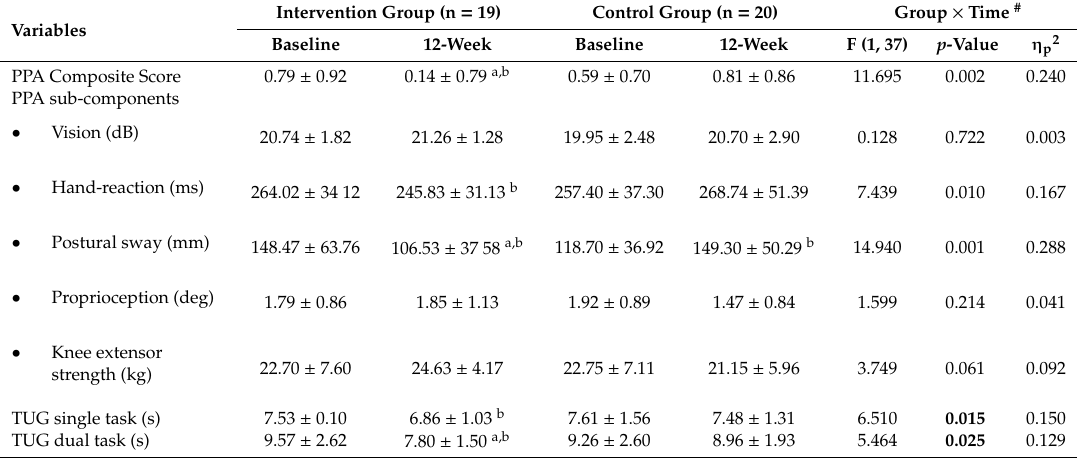
Table 3. Fall risk between the combined physical-cognitive training and control groups at baseline and the end of the 12